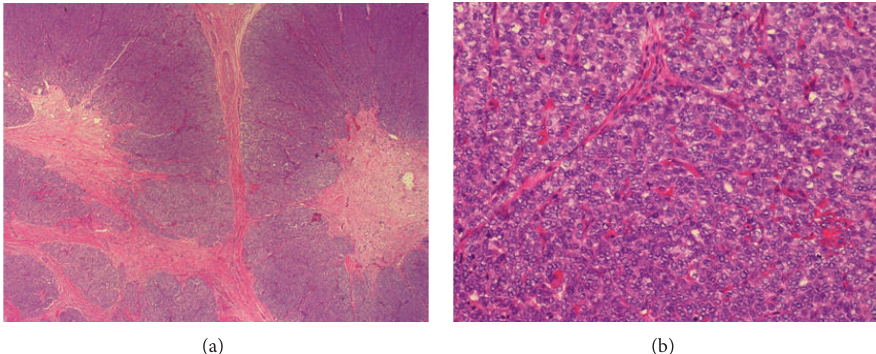
Figure 2: (a) Thyroid, total thyroidectomy. Widely invasive follicular carcinoma, 4.5 cm, with lymphovascular invasion and extracapsular extension. Negative margins. (b) Lymph node negative for malignancy.